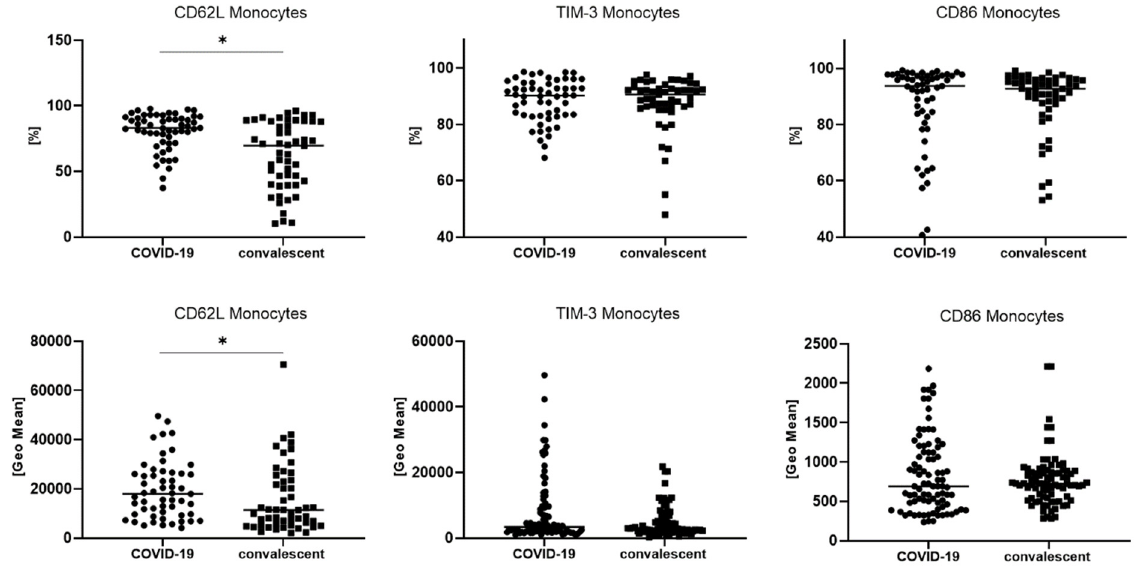
Figure 5. The differences between COVID-19 and convalescent patients for geometric mean expression of CD62L, TIM-3 and CD86 on monocytes. Graphs show the median values (Min–Max). Significant differences in the cell proportion between COVID-19 and convalescent patients in the Mann–Whitney U test presented as * ( p < 0.05). Table 4. Median proportion and median geometric mean expression of TIM-3, CD62L and CD86 markers on monocytes between patients with COVID-19 and convalescent patients with COVID- 19. Data expressed as median (Q1–Q3). (* p < 0.05 Mann–Whitney U test).